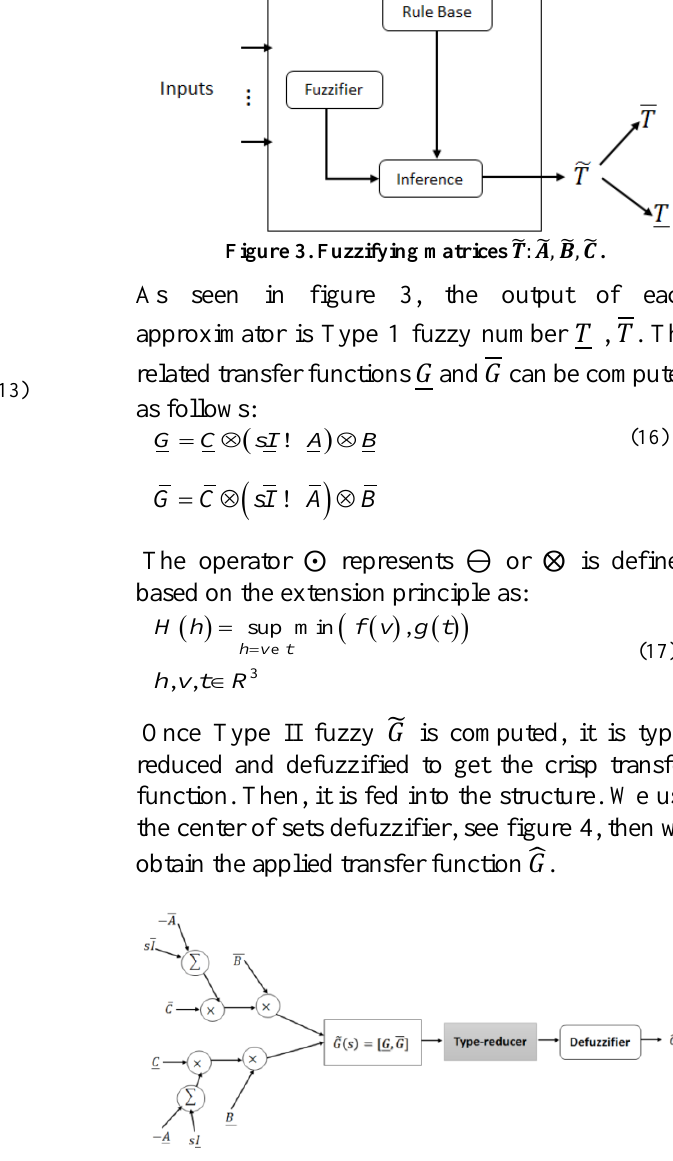
Figure 4. Applied transfer